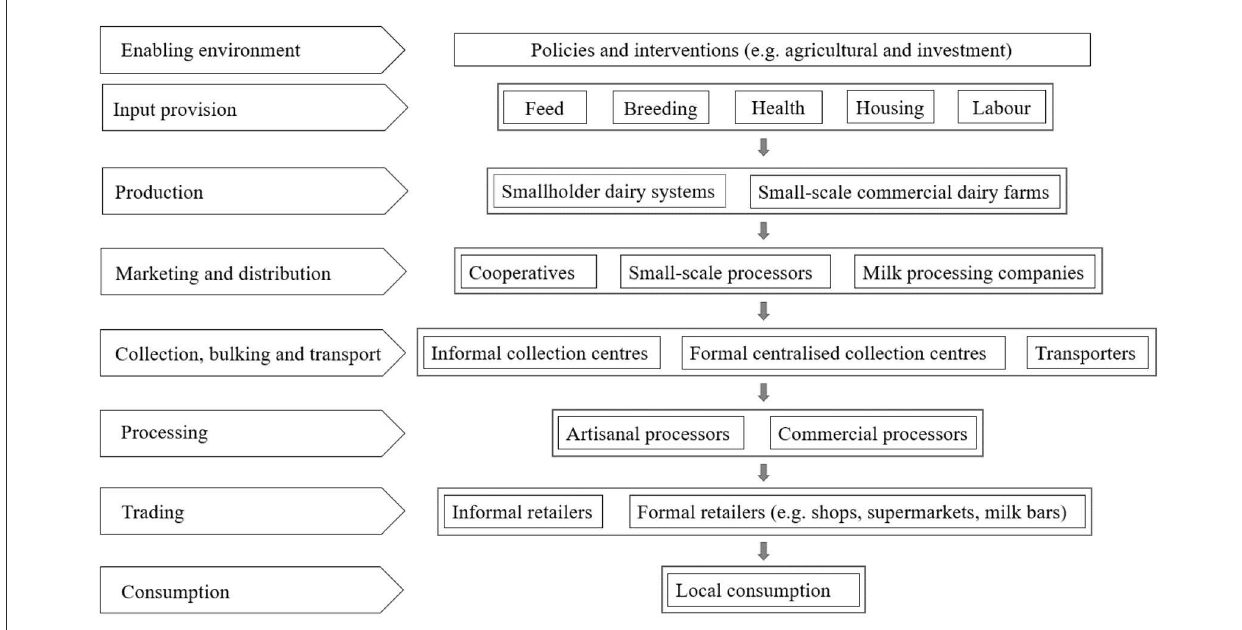
FIGURE2 Milk value chain in